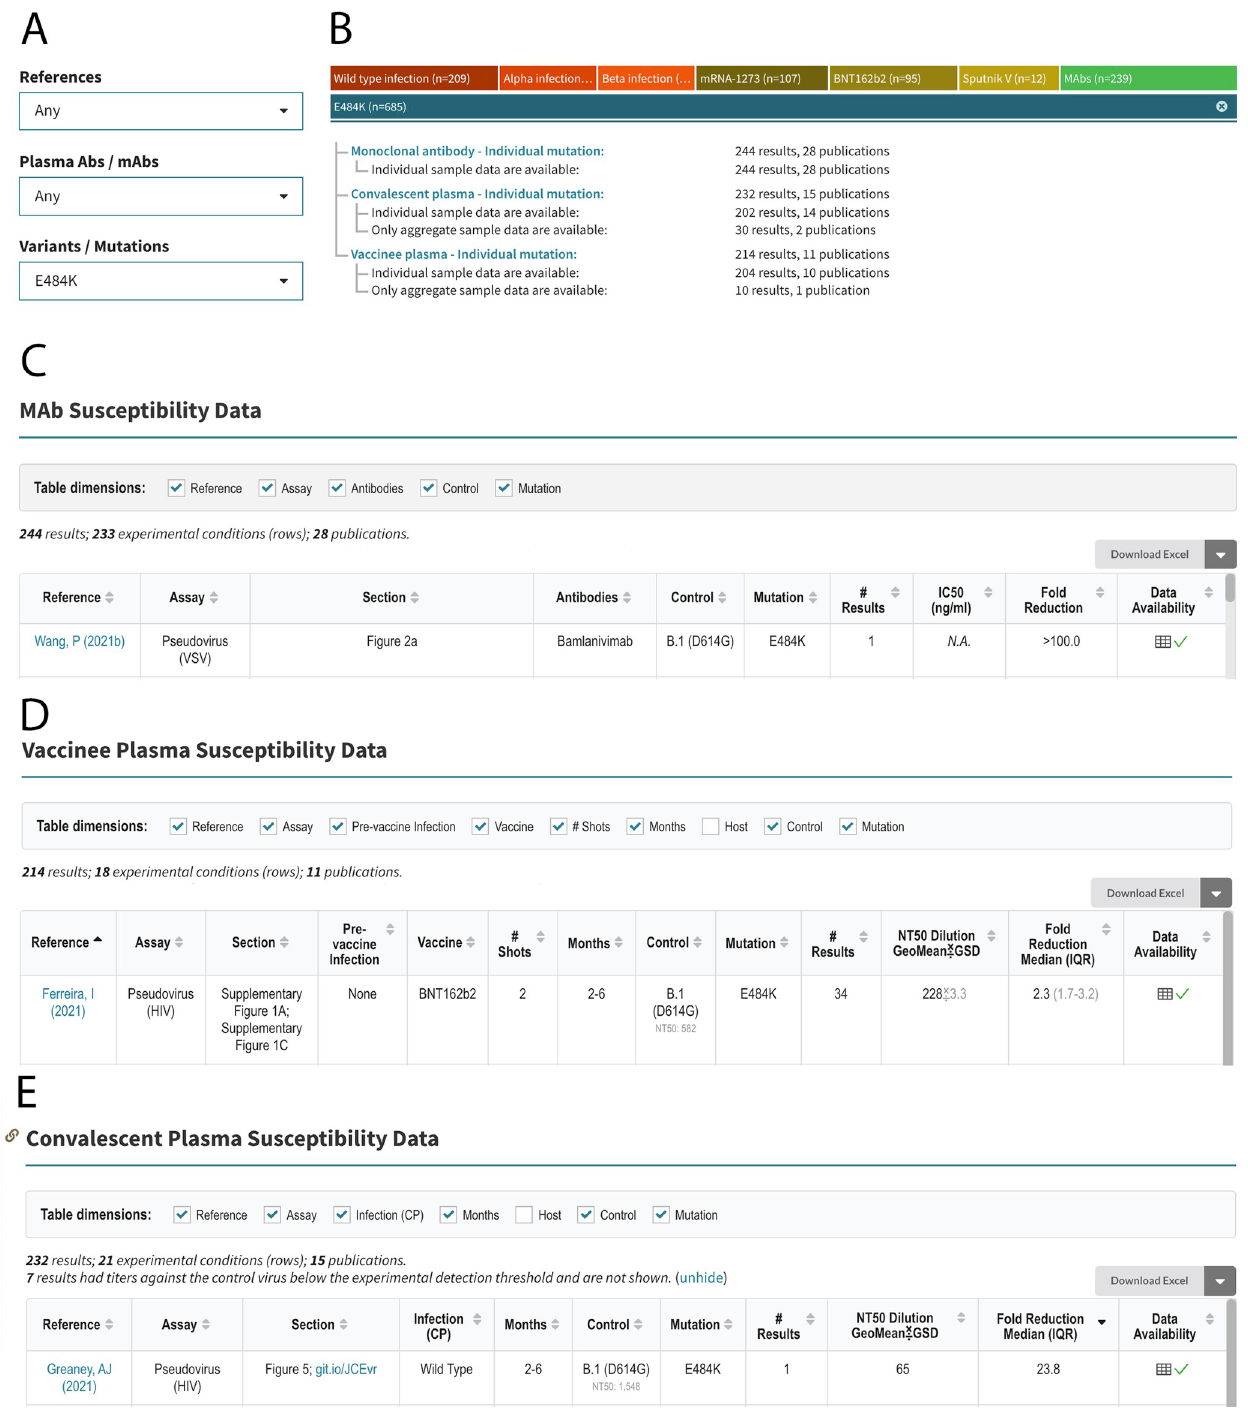
Fig 3. Query interface, sample query, and outline of query results for an example query for the SARS-CoV-2 RBD mutation E484K. The query interface containing three dropdown boxes is shown at the upper left (A). E484K is selected from the “Variants / Mutations” dropdown box. The upper right summarizes the data returned by the query, which in this case includes 244 mAb neutralizing susceptibility results from 28 publications, 232 convalescent plasma (CP) results from 15 publications, and 214 vaccinee plasma (VP) results from 11 publications (B). The summary distinguishes between results for which only aggregate (mean or median) data are provided and results for which individual data are provided. The sections below show the headers and first row of the tables containing mAb (C), VP (D), and CP (E) susceptibility results. The figure was modified from a screenshot captured in October 2021. The updated and complete contents of these tables can be found on the web (https://covdb.stanford.edu/search-drdb/?host=human&mutations=S%3A484K).